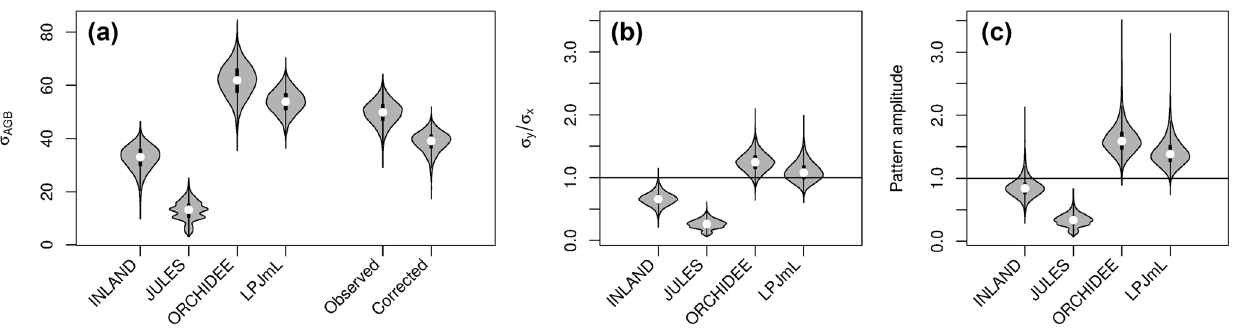
Figure 4. (a) Standard deviations of AGB (in MgCha − 1 ) for the four models and observational data (for the other allometric equations see also Table S2, S3). For the observational data, the global variability at the point scale (“observed”) and the corrected variability at the pixel scale (“corrected”) is given; (b) ratio of standard deviations without correcting for within-pixel variability (c) corrected metrics of pattern amplitude ( σ y /σ x, corr ) .